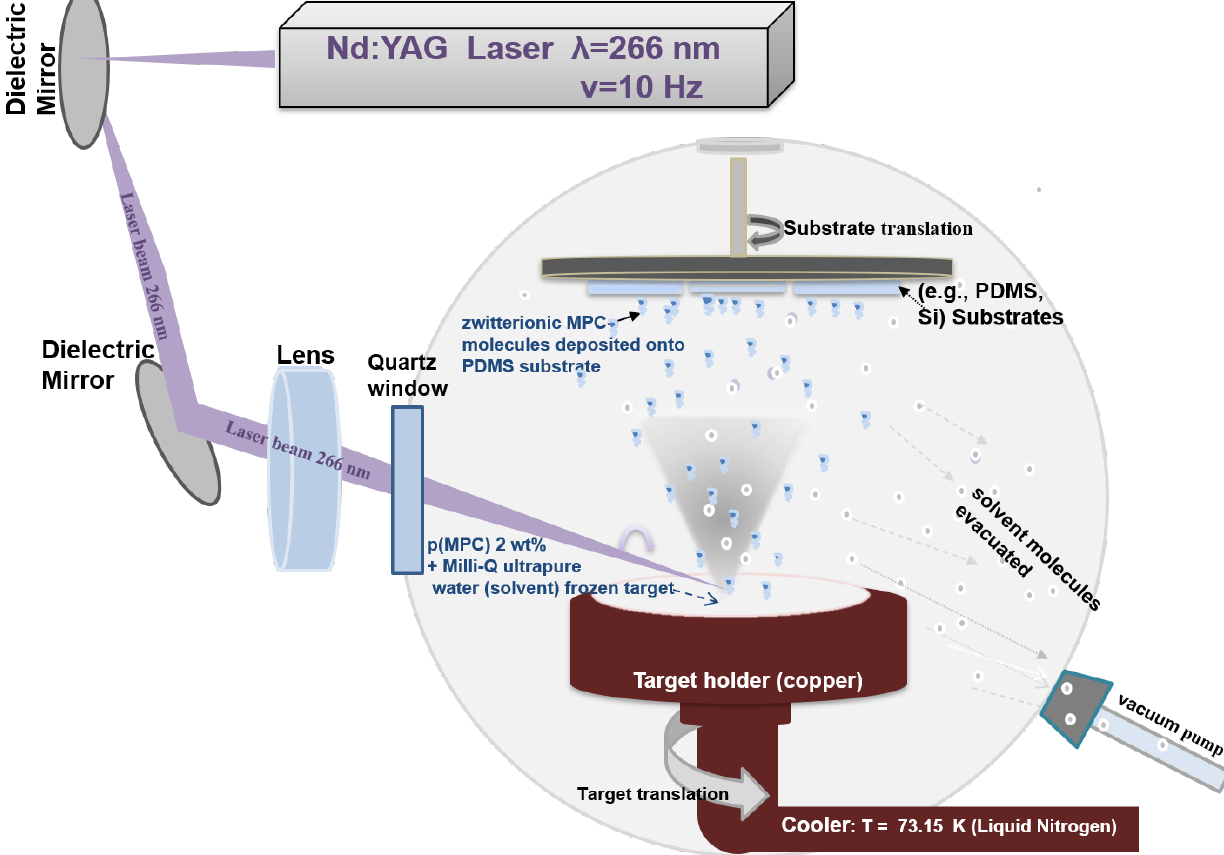
Figure 1. The experimental MAPLE set-up for obtaining pMPC coatings.